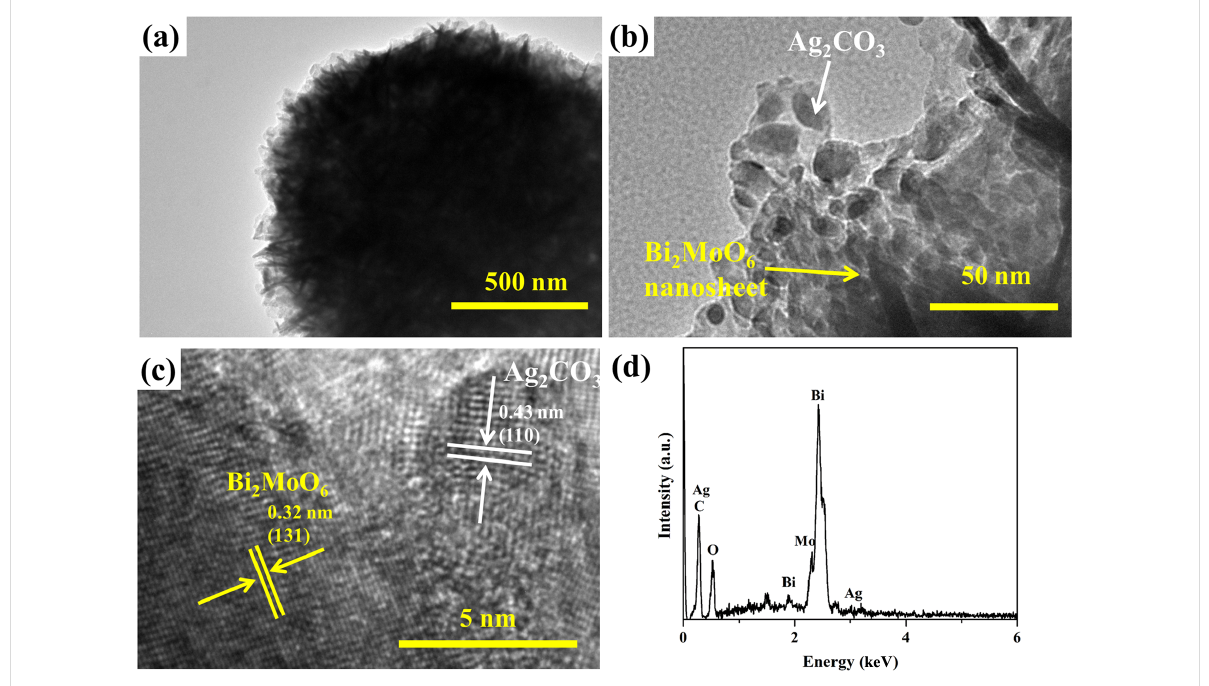
Figure 3: (a–c) TEM images of ACO/BMO-30; (d) EDS pattern of ACO/BMO-30.